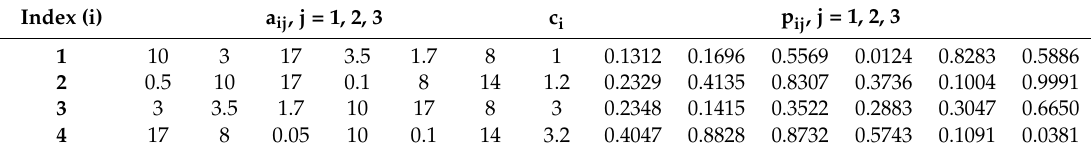
Table 7. Coefficients of Hartman’s Functions (F20).